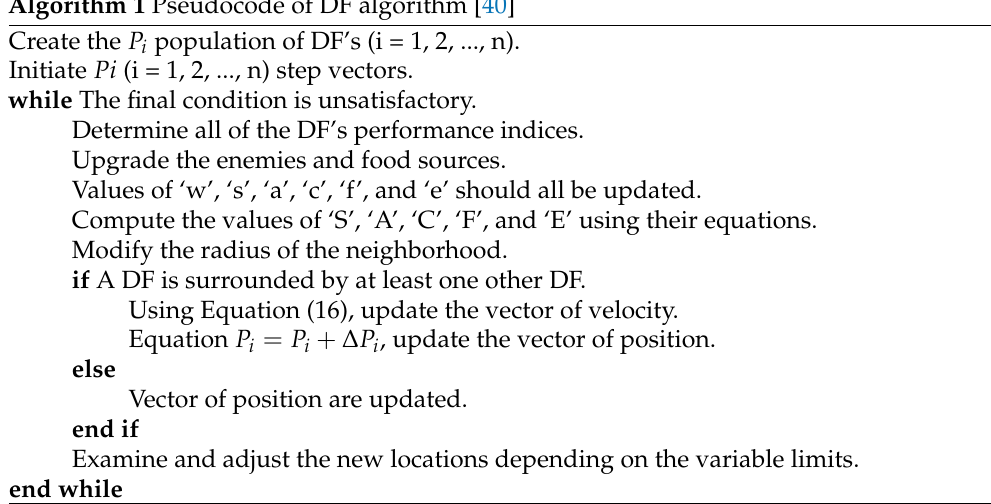
Algorithm 1 Pseudocode of DF algorithm